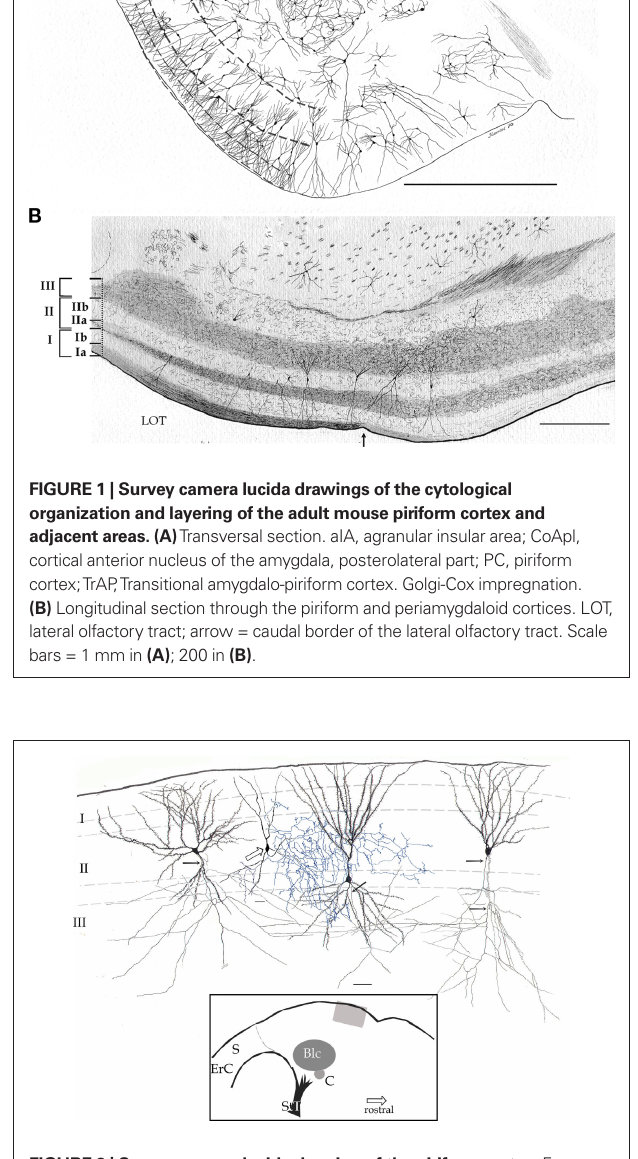
Figure 2 | Survey camera lucida drawing of the piriform cortex. Four pyramidal cells with their fully impregnated proximal axons (arrows) are shown. Axon collaterals run diagonally, distributing in the neuropil of layers II and III. The axon (blue) of a chandelier cell (hollow arrow) distributes in layer II and to a lesser extent III. Rapid-Golgi technique, adult mouse brain. Scale bar = 20 μm. Blc, basolateral complex of the amygdala; C, central nucleus of the amygdala; ErC, entorhinal cortex; S, subiculum; StT, stria terminalis. Calibration bar = 50